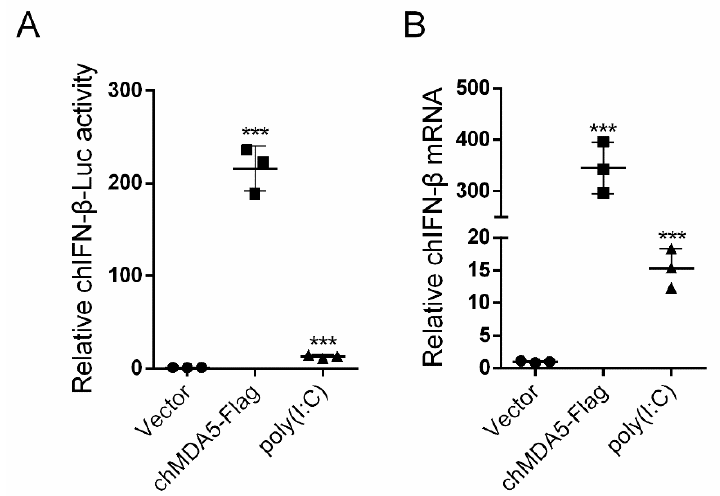
Figure 1. chMDA5 and poly(I:C) transfection significantly increased chIFN- β expression. ( A ) DF1 cells in 12-well plates were transfected with 0.5 µ g control vector, chMDA5, or poly(I:C) together with 0.5 µ g chicken IFN- β promoter reporter plasmid (chIFN- β -luc) and 10 ng control plasmid Renilla. After 24 h, cells were lysed, and firefly and Renilla luciferase activities were measured in accordance with the instructions of the manufacturer. ( B ) DF1 cells in 12-well plates were transfected with 0.5 µ g control vector, chMDA5, or poly(I:C). After 24 h, total RNA was extracted, and the chIFN- β mRNA was determined by qRT-PCR. The values are shown as the mean and SD and are representative of three independent experiments. Data were analyzed using Student’s t -test. ***, p < 0.001.